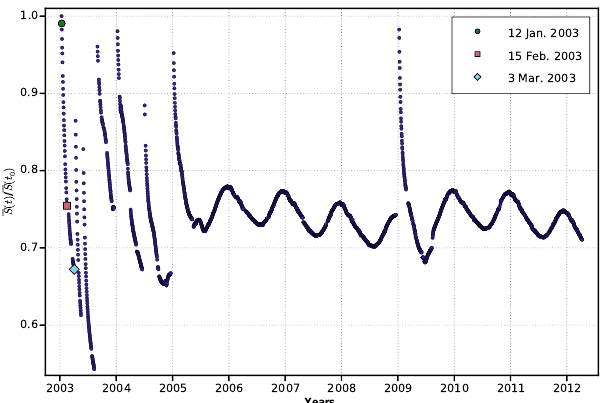
Figure 3. Mean signal of SCIAMACHY’s daily sun mean reference (SMR) measurements (2288.72–2383.77nm) as a function of time relative to 11 January 2003. Three example orbits are marked.